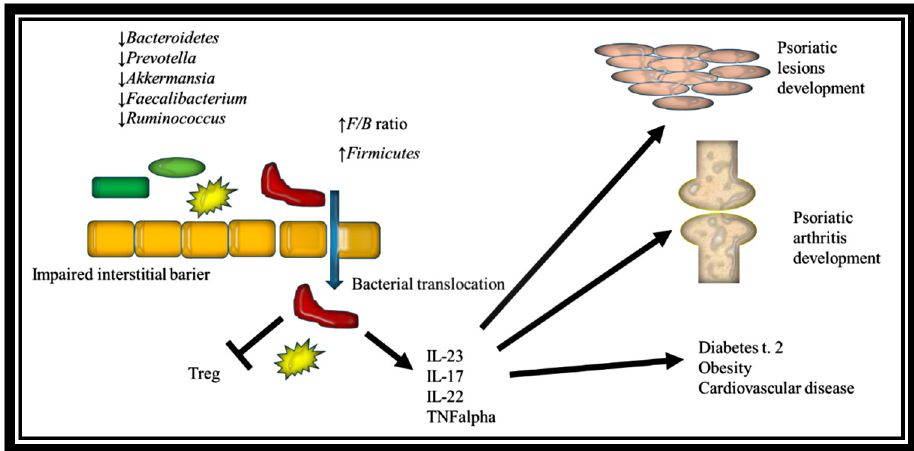
Figure 1. The impact of gut dysbiosis in psoriasis on the development of psoriatic lesions, psoriatic arthritis, and psoriasis comorbidities ( F/B ratio - Firmicutes-to-Bacteroidetes ratio; Treg - T regulatory cells; TNFalpha - tumor necrosis factor alpha).